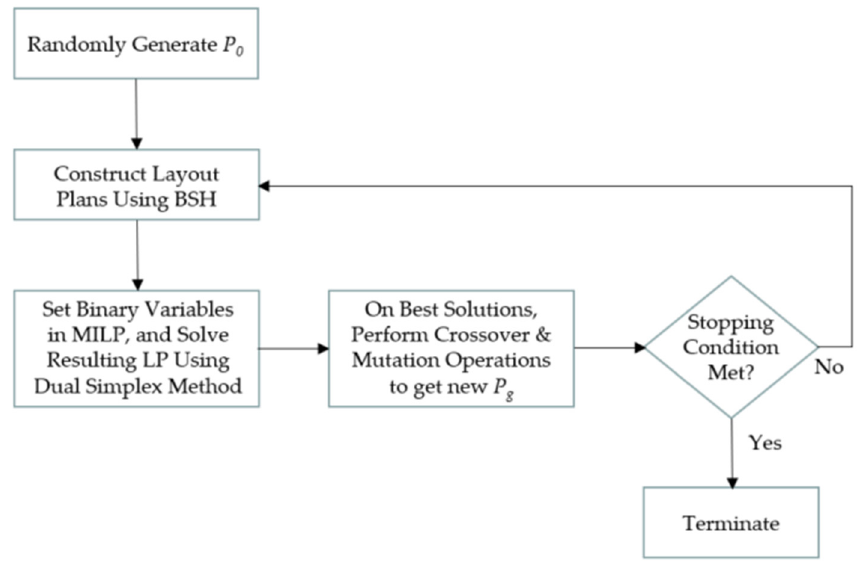
Figure 2. Flow diagram of the stages of the proposed GA.